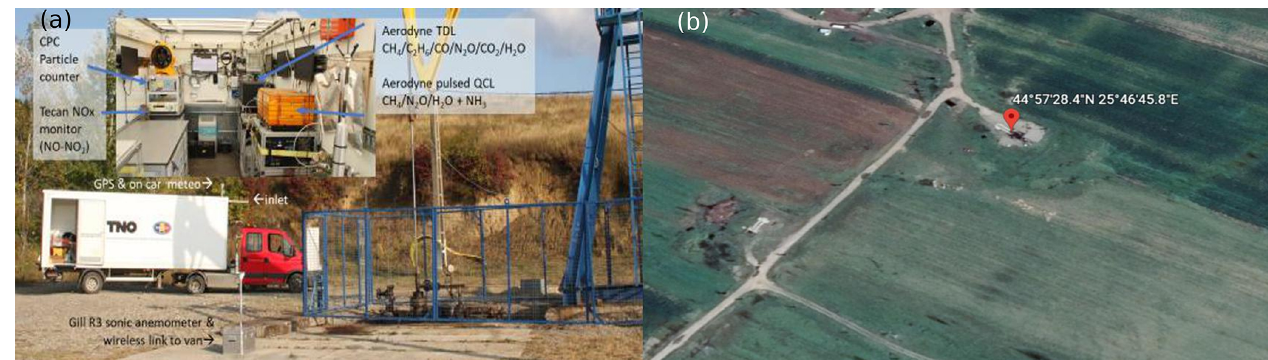
Figure 1. (a) (Inset figure) The measurement setup inside the TNO vehicle. (Main figure) The TNO vehicle used in the measurement campaign, the location of the inlet is indicated on the figure. (b) Google Earth view of the measurement site with the oil well location pointed out. © Google Earth, Maxar Technologies.